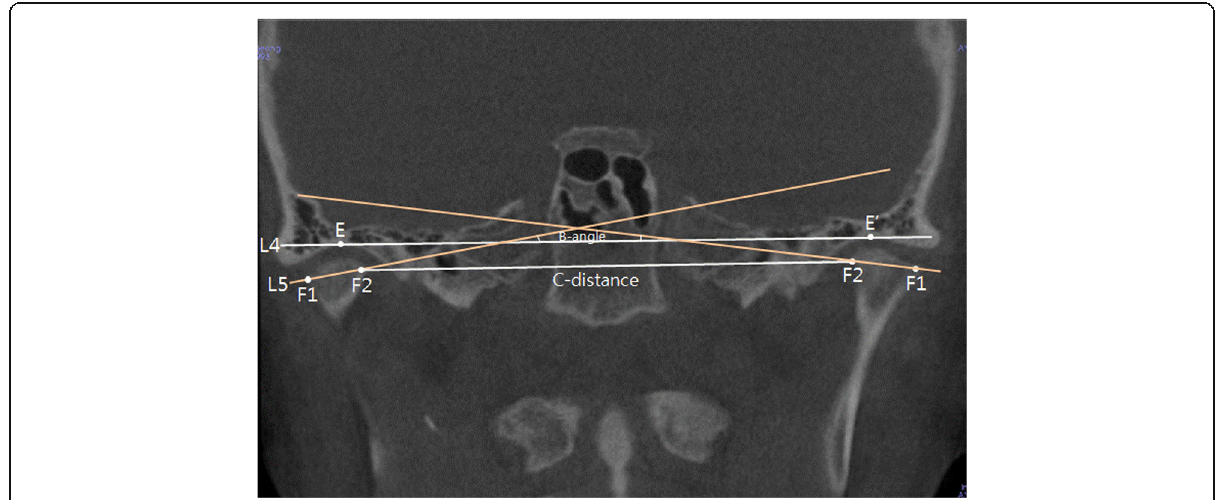
Fig. 3 Reference points and measurement of coronal view in CBCT. E,E ′ highest point with joint, F1 outer pole of condylar head, F2 inner pole of condylar head, L4 line passing E and E ′ , L5 line passing F1 and F2, B-angle angle between L4 and L5, C-distance distance between left F2 and right F2